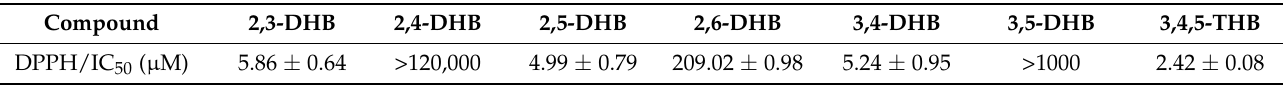
Table 1. DPPH antioxidant activity of the tested hydroxybenzoic acids (methanolic solutions) measured after 60 min of reaction time. Mean values from three independent experiments ± SD are shown.